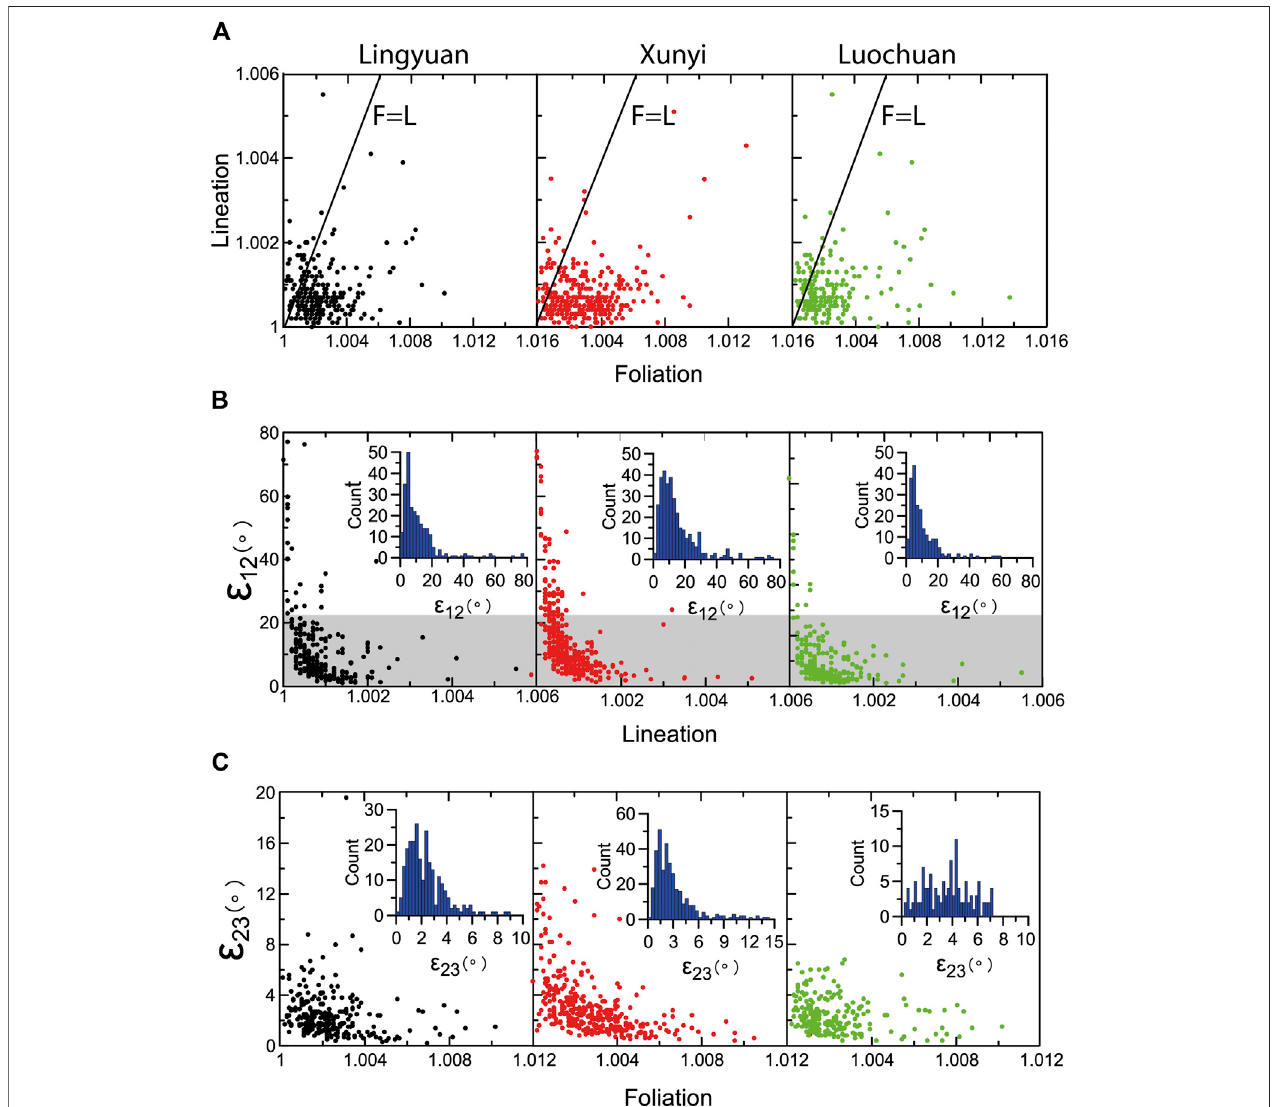
FIGURE2|(A) Flinn-typeplotsoflineation(L)vs.foliation. (B) Plotsof Ɛ 12 (the95%con fi denceellipseofK max intheplanejoiningK max andK int )againstlineation. (C) Plots of Ɛ 23 (the 95% con fi dence ellipse of K min in the plane joining K int and K min ) against foliation. The inserts are frequency distributions of Ɛ 12 using 2 ° bin sizes (B) and Ɛ 23 using 0.5 ° bin sizes (C)